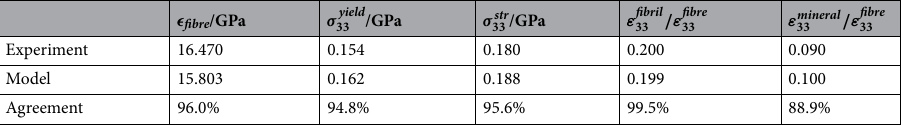
Table 1. Comparison of experimental 39 ( N=11 ) and simulated values from the statistical constitutive model for micro- and nanomechanical fibre properties when considering fibril recruitment.